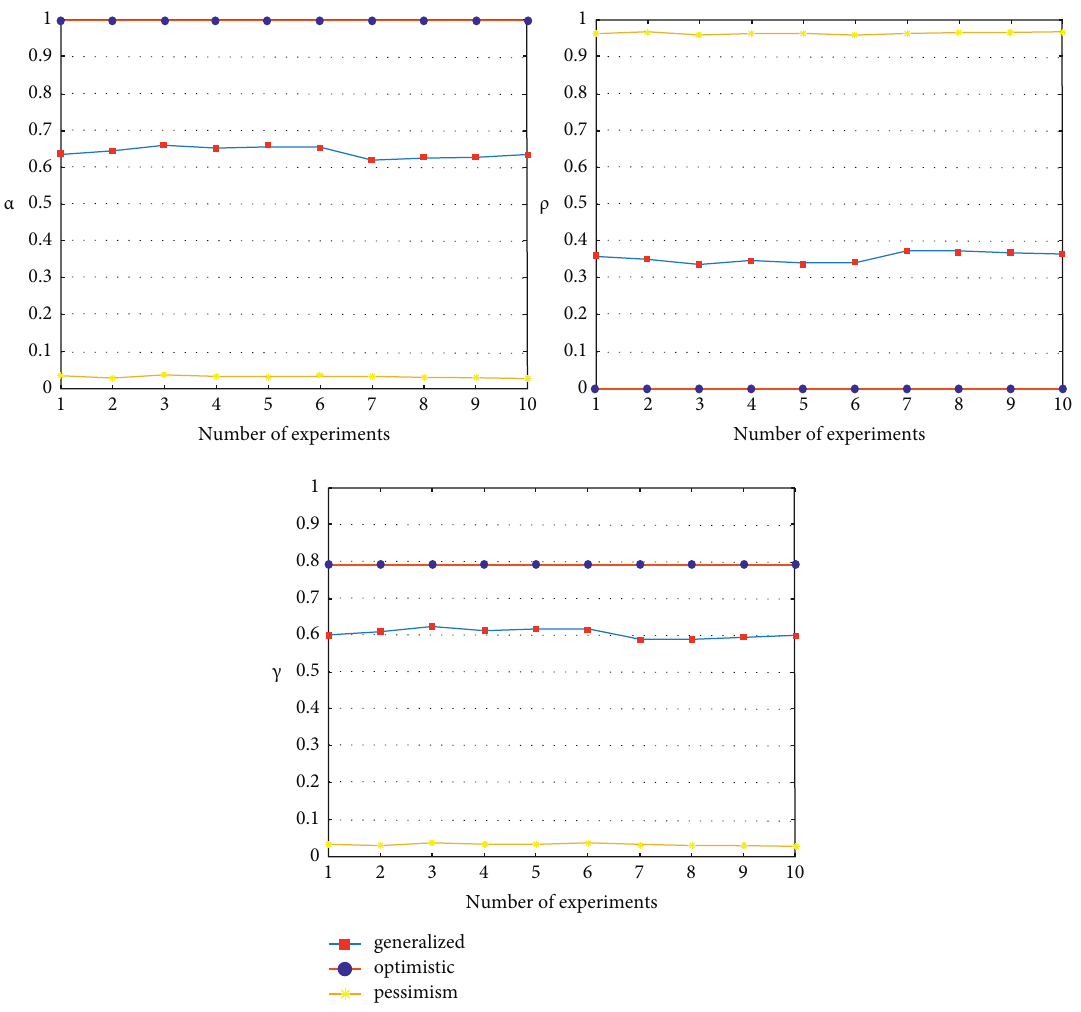
Figure 5: Uncertainty measurement of weighted multigranulation model for